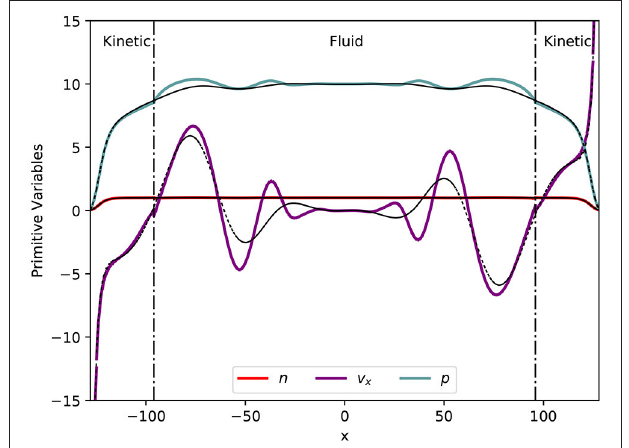
FIGURE 11 | Electron sheath density, velocity, and pressure moments at t 20 /ω p e with direct variable translation. The middle domain is solved using = the 5 N -moment two-fluid plasma model while the left and right domains are solved using the continuum kinetic two-species plasma model. Simulation results from applying the continuum kinetic model for the entire domain are plotted in black dashed lines for comparison. Some solution mismatch is seen due to departure of the electron distribution function away from a Maxwellian where the model interface assumes validity of the fluid